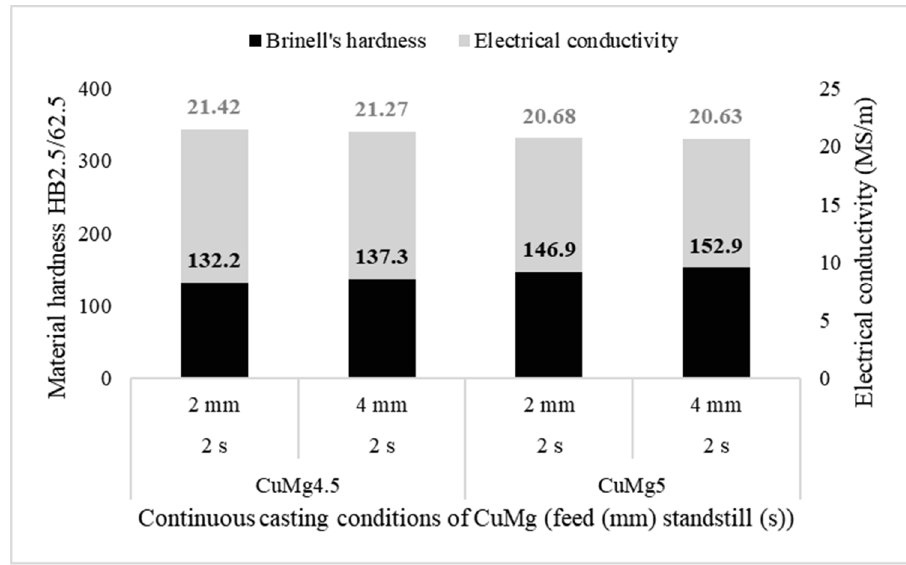
Figure 4. Mean values of electrical conductivity (grey columns) and Brinell’s hardness (black columns) of each of the tested samples.